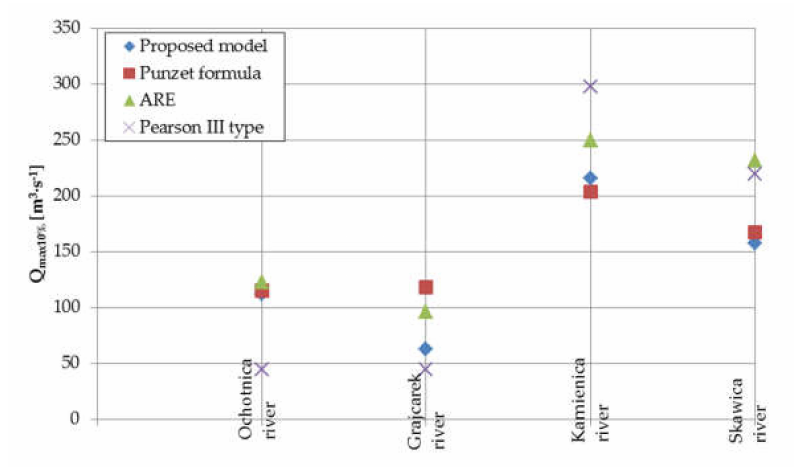
Figure 16. Comparison of Q max10% discharges achieved from proposed model, Punzet formula, and spatial regression equation (ARE) for four